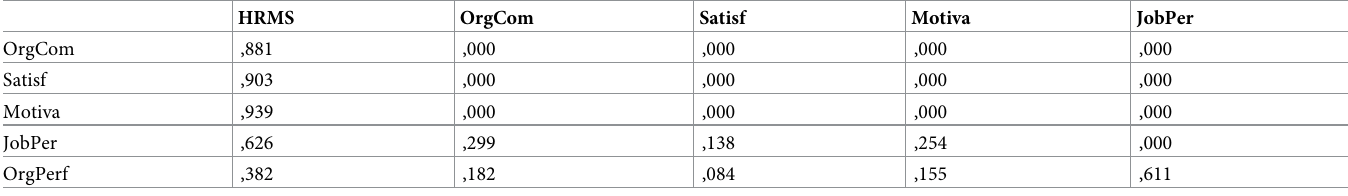
Table 6. Standardized total effects among variables within the